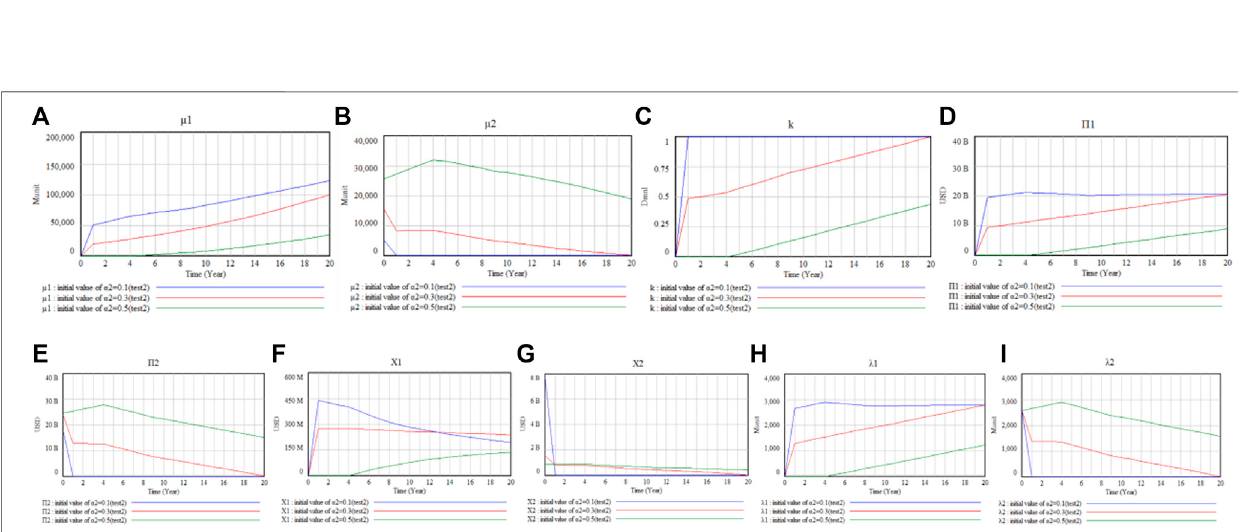
Frontiers in Energy Research |